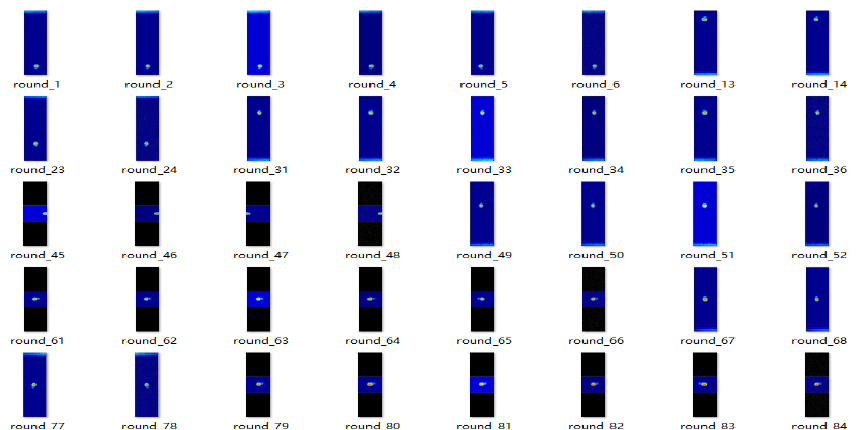
Figure 5. Slot augmented dataset.